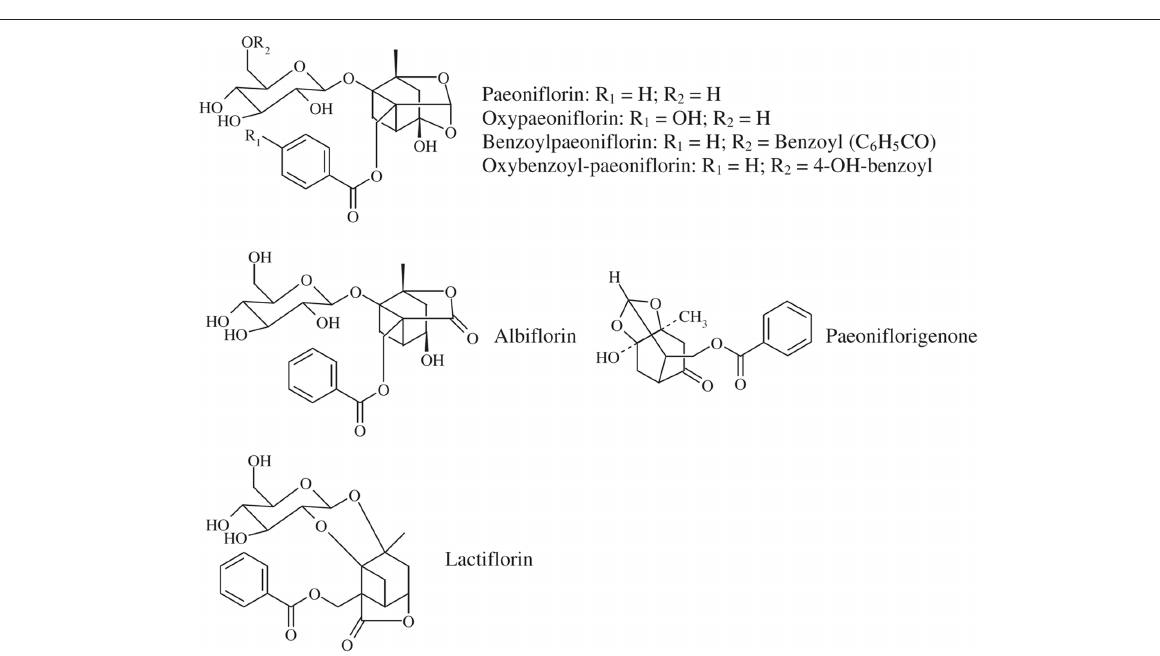
Figure 2 | Chemical structures of main components in total glucosides of